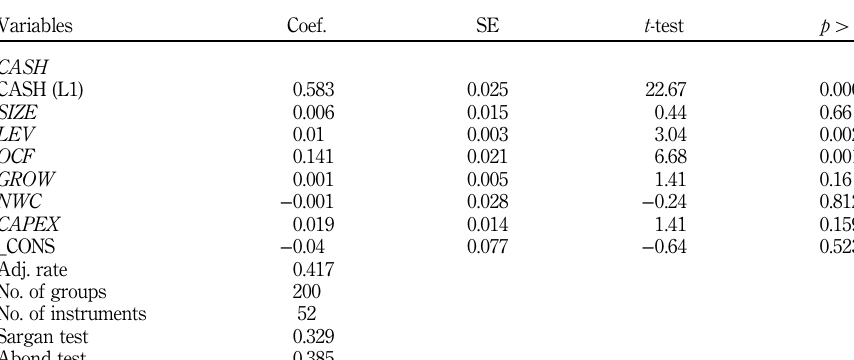
Table V. Dynamic panel data regression results for overall firms